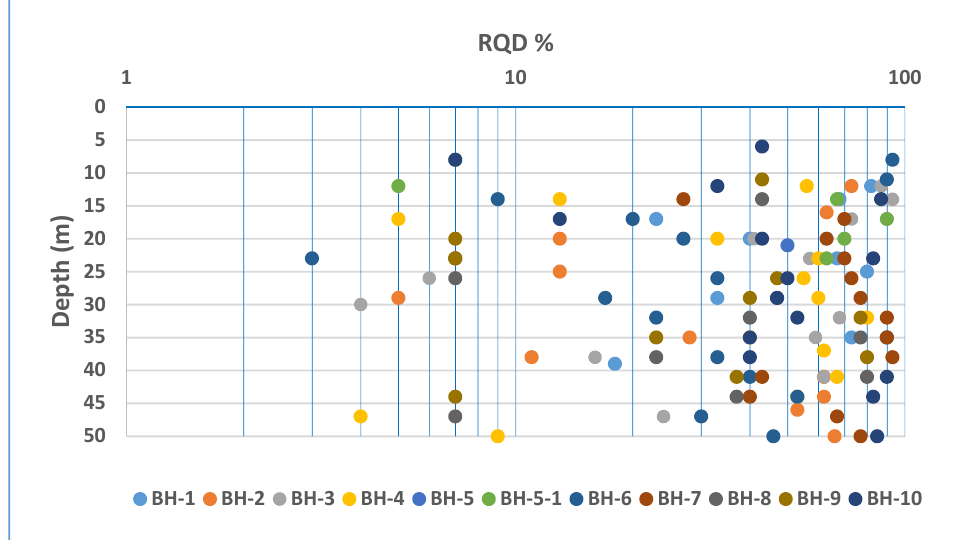
Figure 18. RQD values recorded in BH-series boreholes.